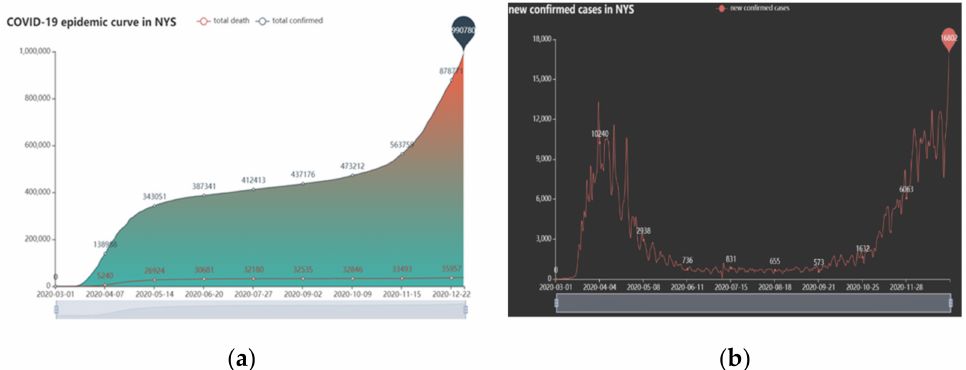
Figure 1. New York State epidemic development curve: ( a ) cumulative confirmed and deaths, ( b ) new confirmed COVID-19